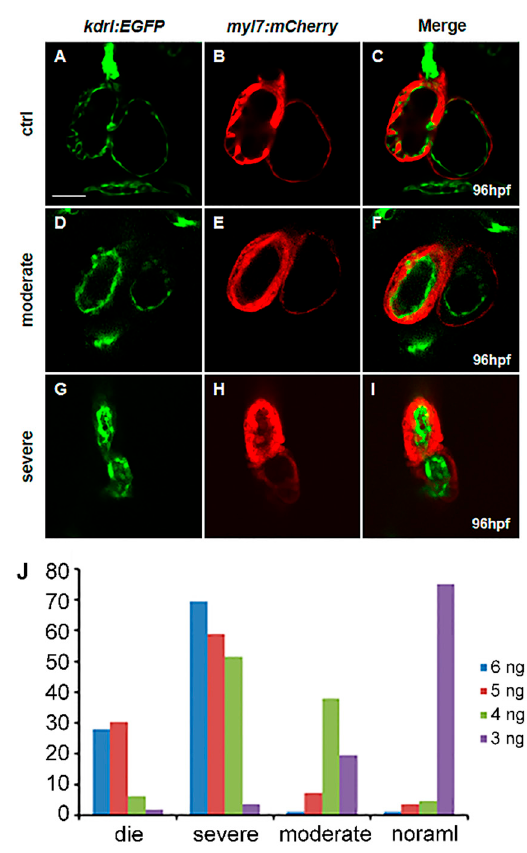
Figure 2. vegfaa regulates heart development in a dose-dependent manner. ( A – I ) Fluorescence micrographs of the hearts of wild-type ( A – C ), vegfaa morphants with moderate defects ( D – F ), and severe defects ( G – I ) at 96 hpf in the background of Tg ( myl7:mCherry ) /Tg ( kdrl:EGFP ) transgenic fish, Scale bar: 50 μ m; ( J ) Statistical analysis of MO dosage and heart malformation in vegfaa morphants.